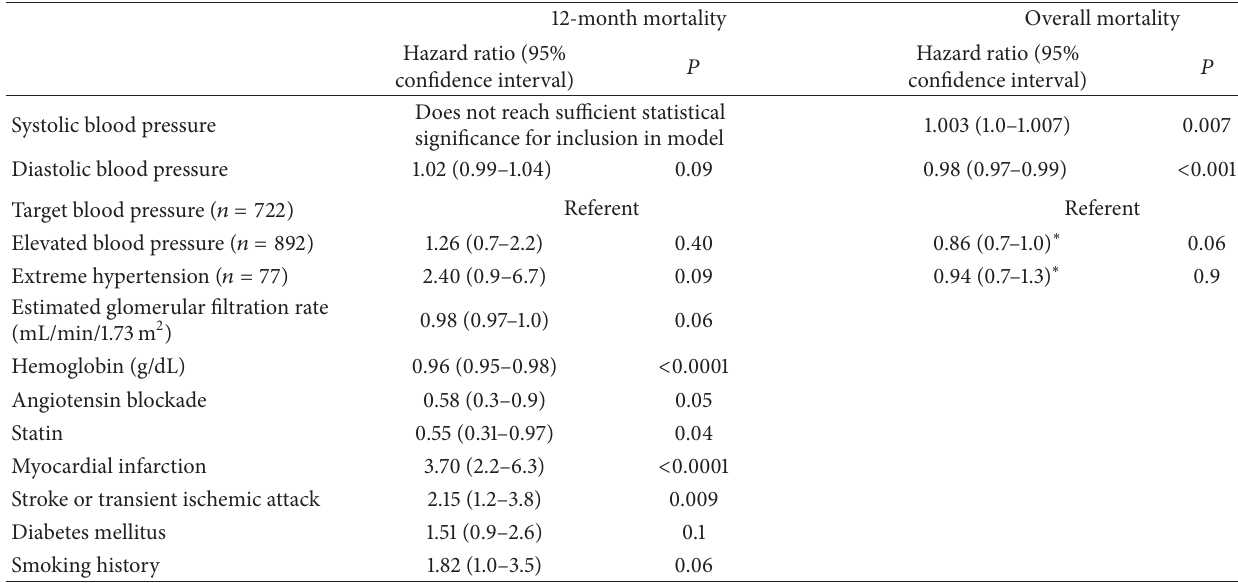
Table 2: Hazard ratio for death for baseline blood pressure variables.